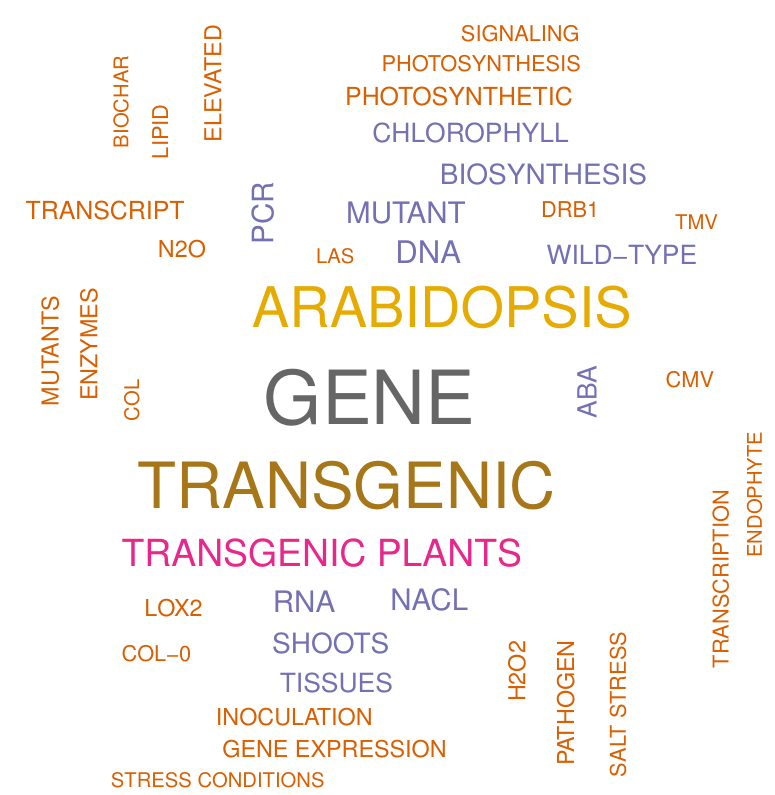
Figure 10. Word cloud with the forty most frequent annotations representing the cluster of articles with similar